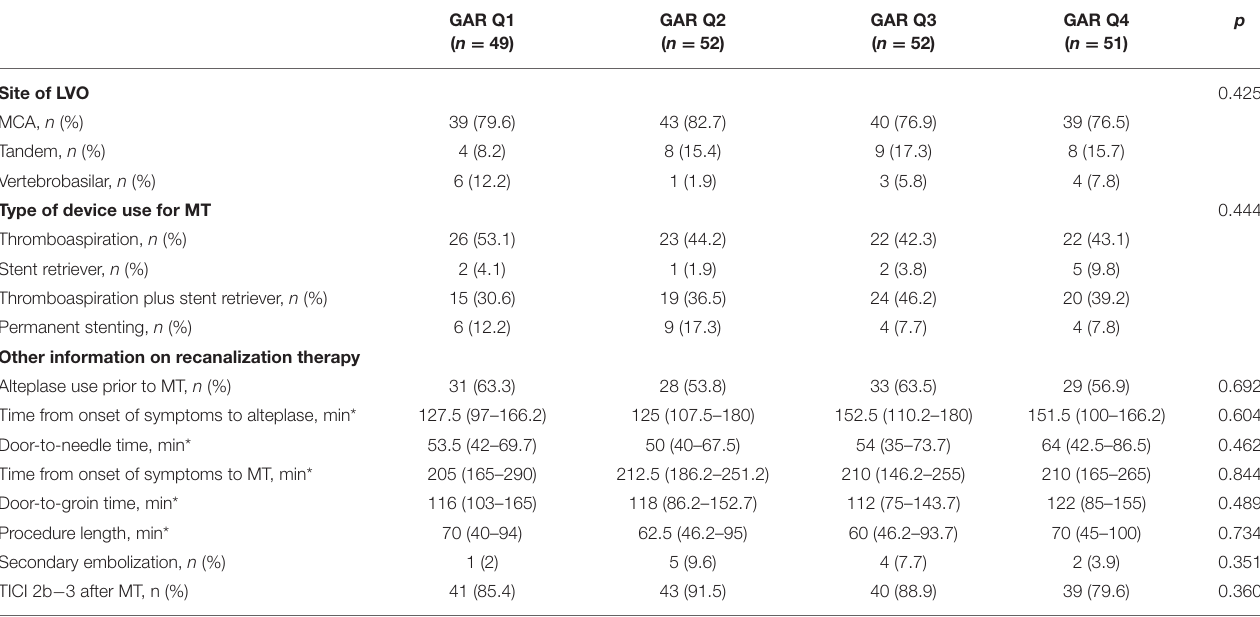
GAR Q1, first glucose-to-glycated hemoglobin ratio quartile; GAR Q2, second glucose-to-glycated hemoglobin ratio quartile; GAR Q3, third glucose-to-glycated hemoglobin ratio quartile; GAR Q4, fourth glucose-to-glycated hemoglobin ratio quartile; LVO, large vessel occlusion; MCA, middle cerebral artery; MT, mechanical thrombectomy; TICI, Thrombolysis in Cerebral Infarction. Dataarepresentedasmeanandstandarddeviationfornormallydistributedcontinuousvariables.Non-normallydistributedcontinuousvariablesaredisplayedasmedianandinterquartile range and are identified by an asterisk ( *